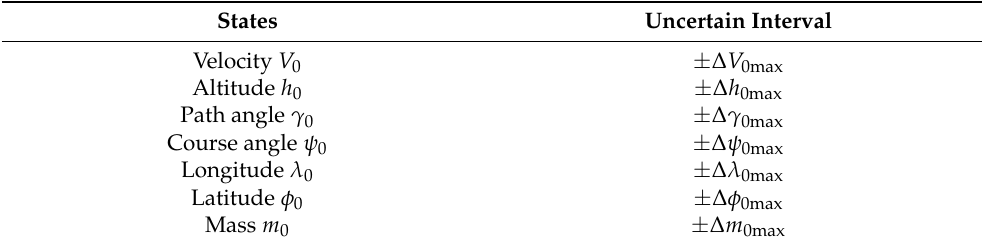
Table 1. Uncertainty of flight state.